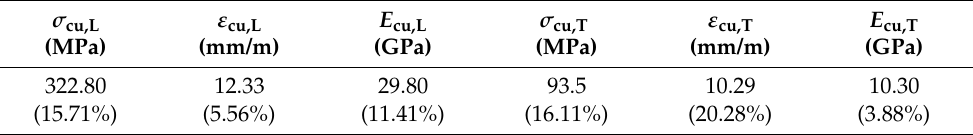
Table 4. Compressive properties of GFRP face sheets/webs (adapted from [34]).